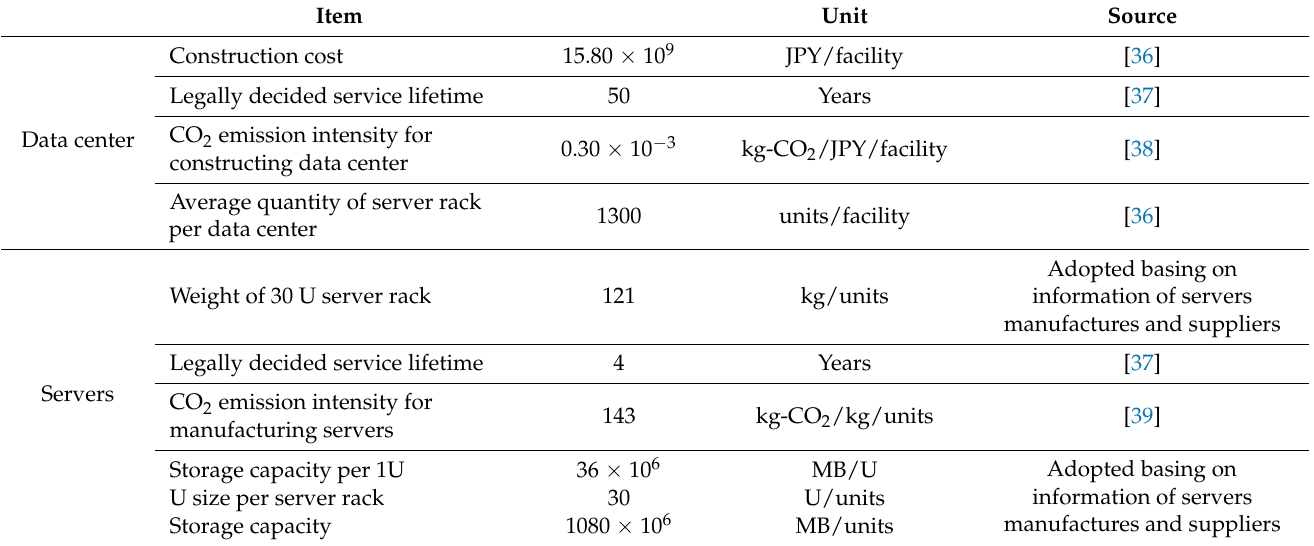
Table 1. Utilized data for construction and manufacture process.